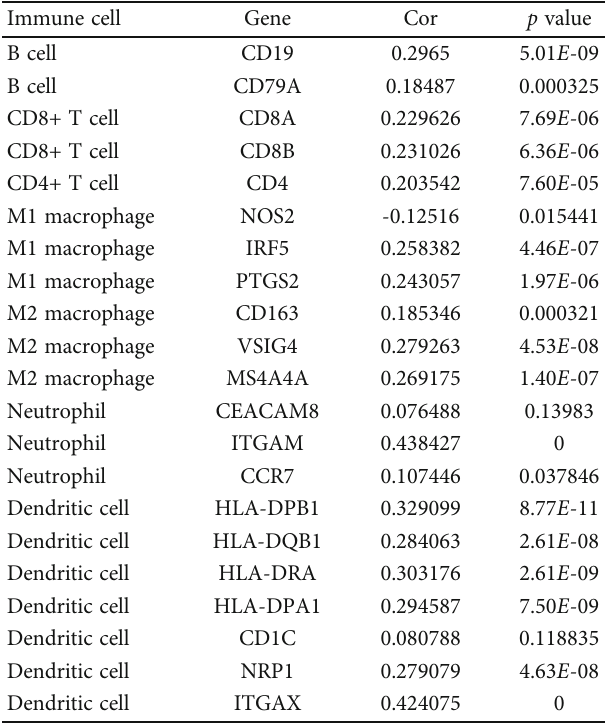
Table 2: Correlation analysis between LPCAT1 and biomarkers of immune cells in